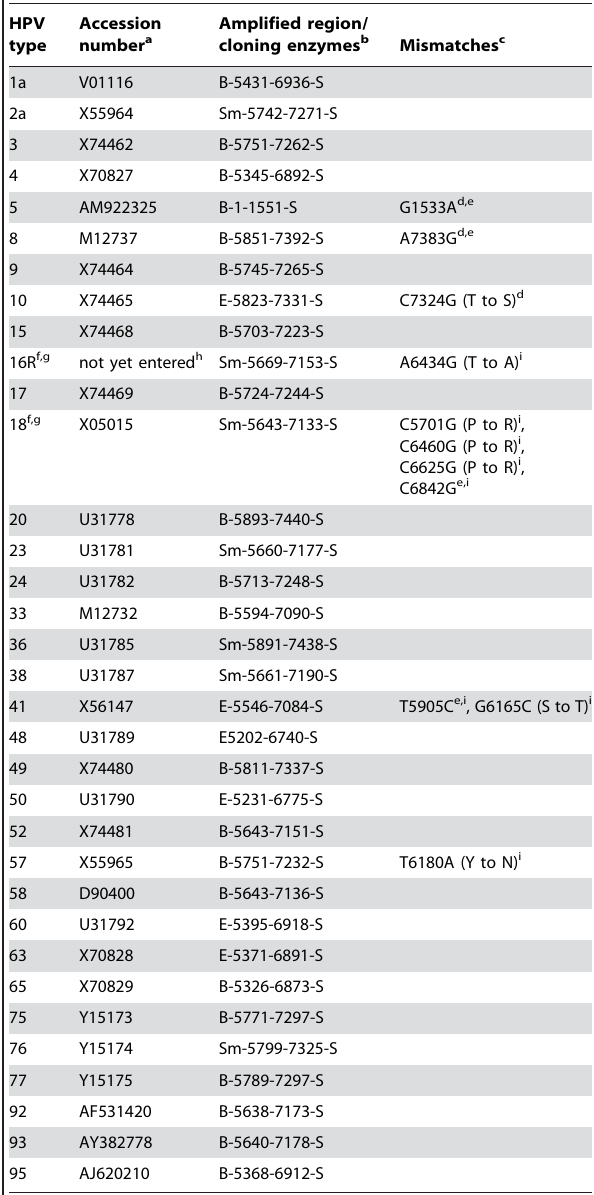
Table 2. Characteristics of expressed HPV L1